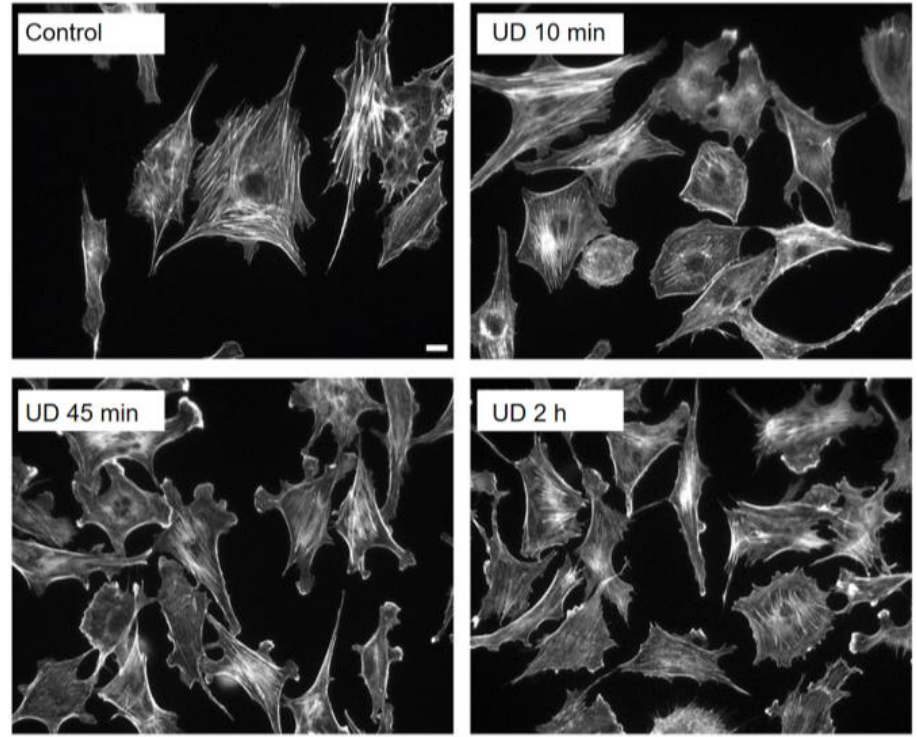
Figure 3. Reduced stress fibers and increased lamellipodia in upside-down cells. BAECs were stained with fluorescent phalloidin to observe actin filament organization as well as the overall cell morphology. Control cells were kept right-side up for 2 h. While control cells had many stress fibers, upside-down (UD) cells transiently lost them and extensively developed lamellipodia. These changes in upside-down cells became less noticeable by 2 h, suggesting that the morphological changes seen in upside-down cells are transient, perhaps due to the adaptation of cells to the upside-down condition. Scale bar: 10 µm.